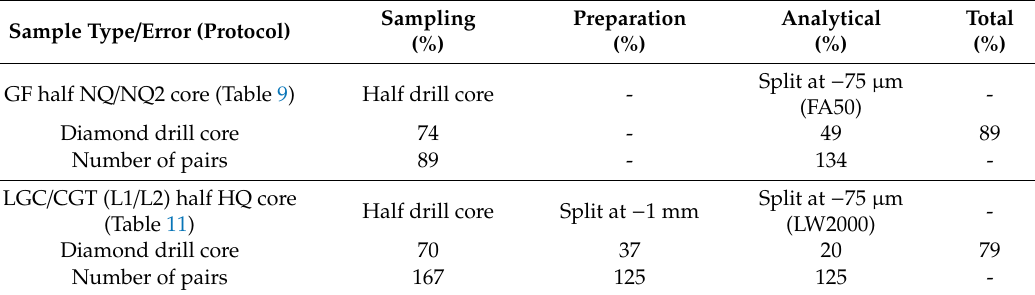
Table 13. NQ / NQ2 and HQ core duplicate pair